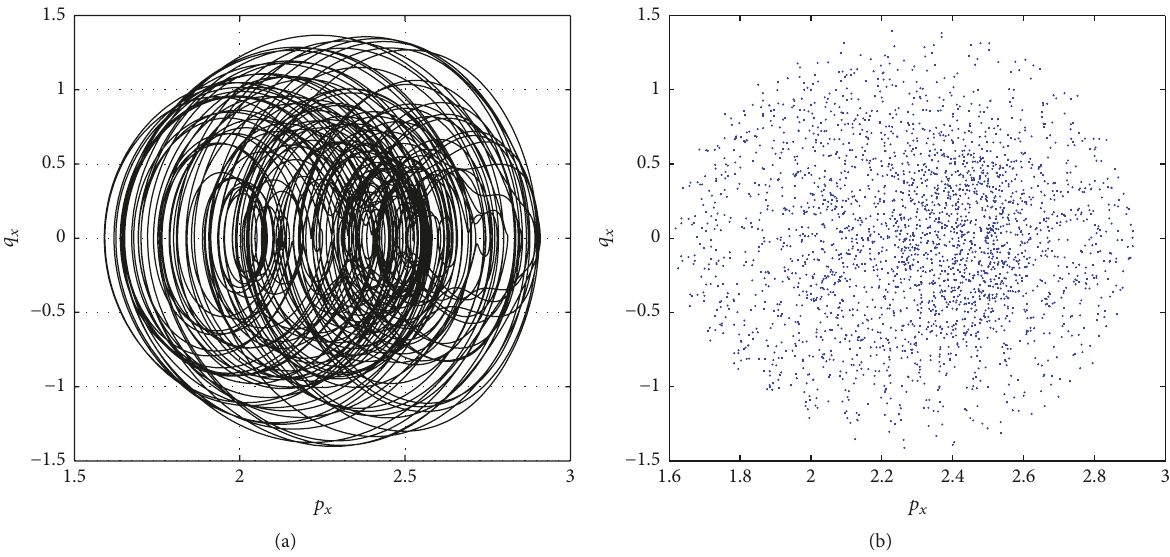
Figure 6: Phase portrait (a) and Poincar´e sections (b) in the plane 𝑝 𝑥 , 𝑞 𝑥 with the initial conditions 𝑞 𝑥𝑜 = 2 , 𝑞 𝑦𝑜 = 1 , 𝑝 𝑥𝑜 = 1 , 𝑝 𝑦𝑜 = 1 , 𝜌 𝑥𝑜 = 1 , 𝜌 = 2 , 𝜉 = 1 , and 𝜉 = 1 . We set the quadratic coupling parameters as 𝜎 = 0.1 , 𝜅 = 5 , and 𝛼 = 0.1 𝑦𝑜 𝑥𝑜 𝑦𝑜